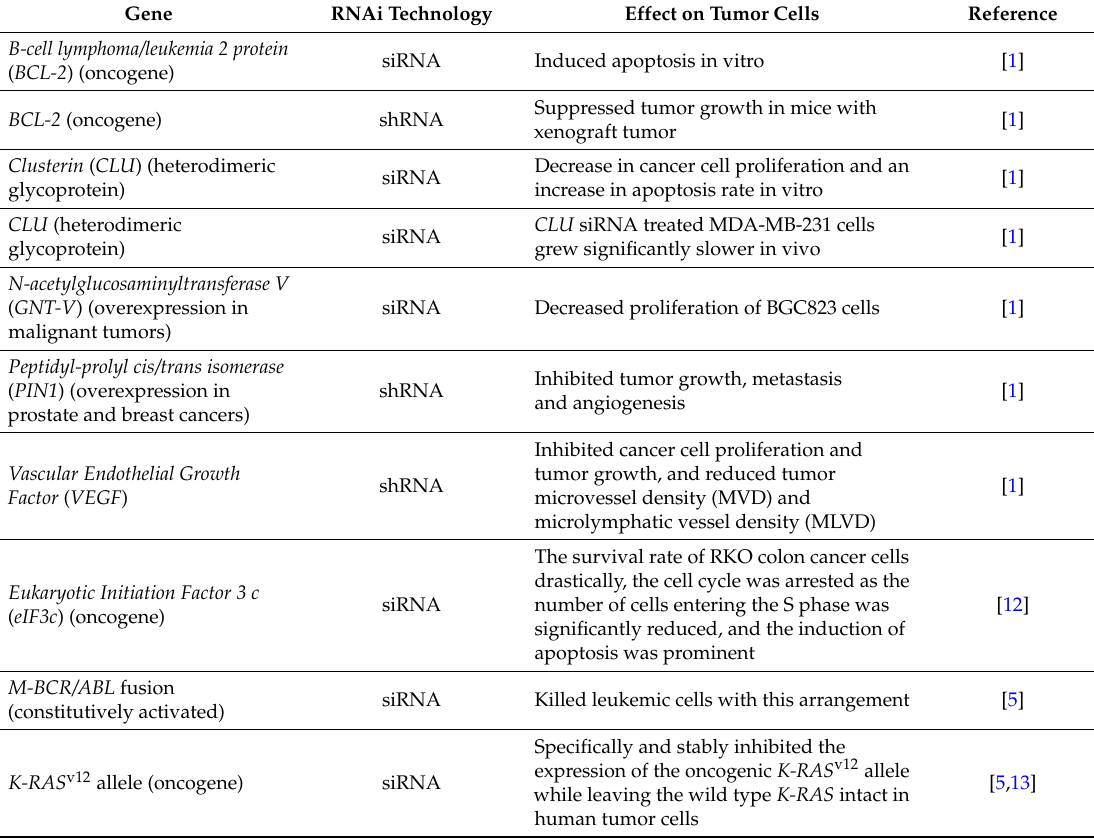
Table 1. Examples of RNA interference (RNAi)-based therapy under preclinical research.